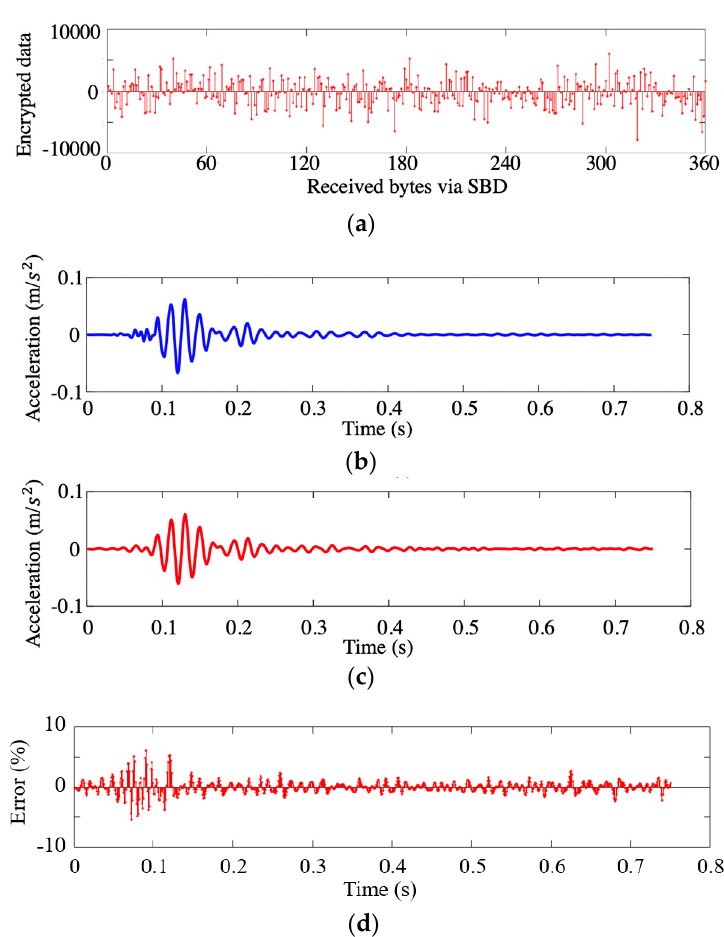
Figure 5. Data recovery results of the measured acceleration by sensor 4: ( a ) Encrypted data; ( b ) original measurements extracted from backup file; ( c ) recovered data from SBD data transferred via satellite communication; and ( d ) comparison and reconstruction error.